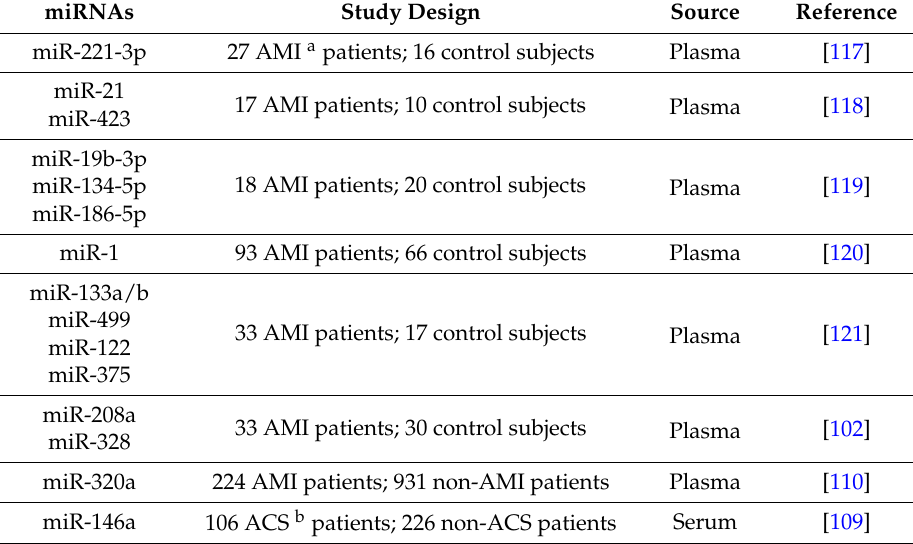
Table 1. Circulating miRNAs as diagnostic biomarkers for MI. miRNAs Study